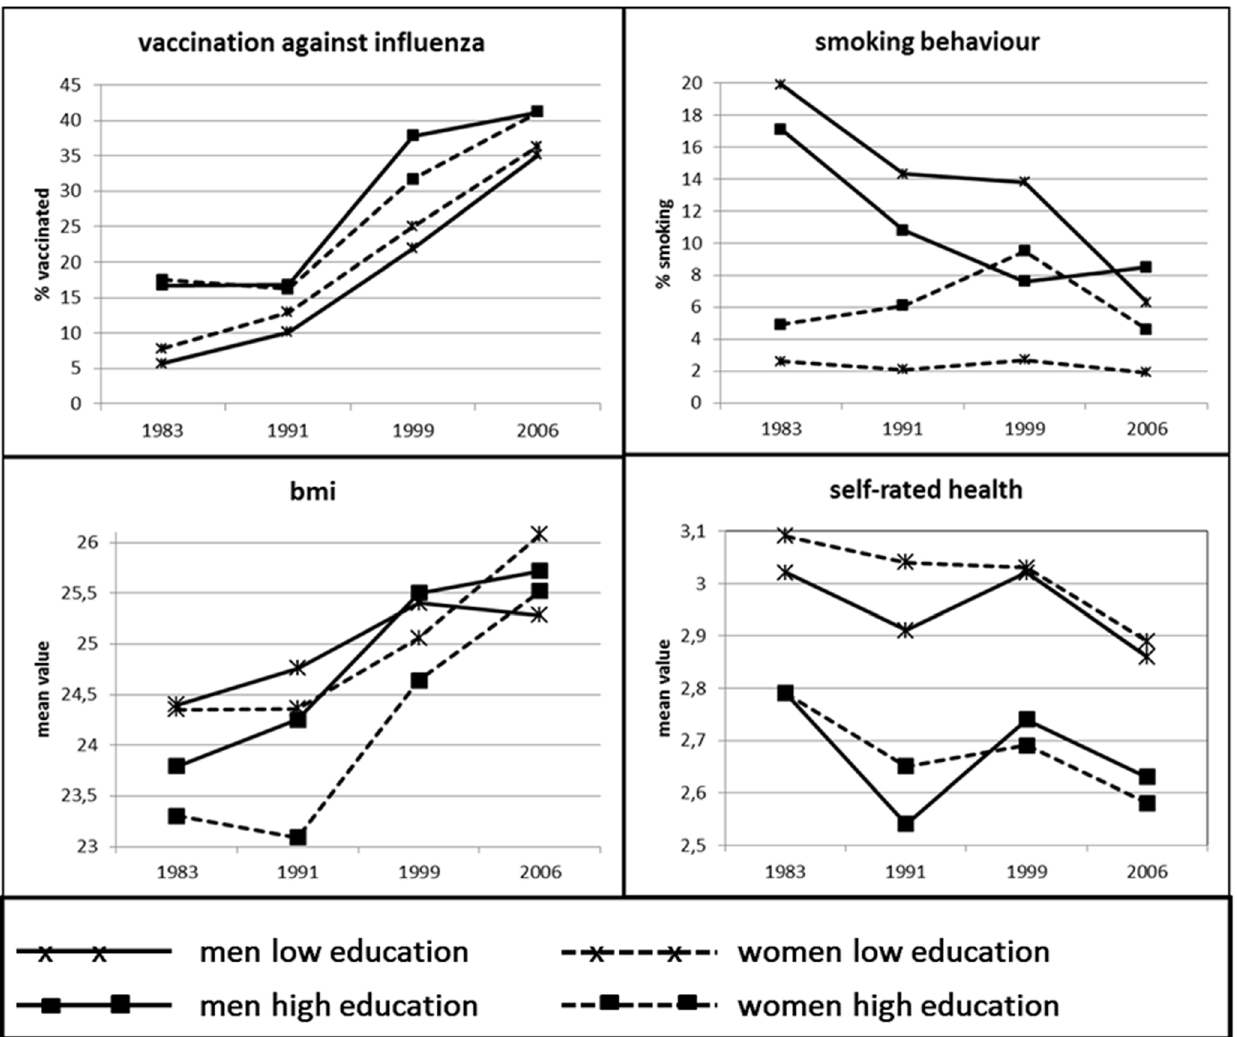
Figure 1. Long-term-trends of health and of health- and risk behaviour in persons 75 years and older.